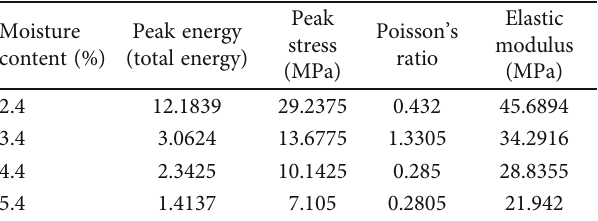
Table 2: Mechanical parameters of coal samples under di ff erent water